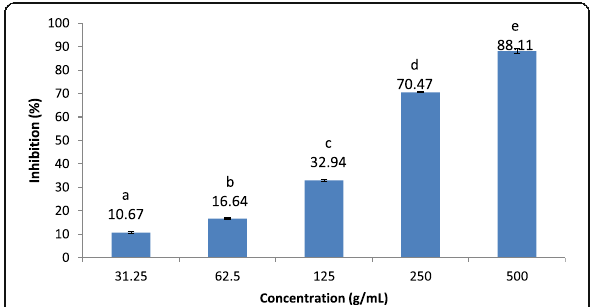
Fig. 2 Xanthine oxidase inhibitory activities of ethanol extract of bark of Flacourtia indica. Results are presented as mean ± SE ( N = 3). Means followed by the same letter are not significantly different at p <